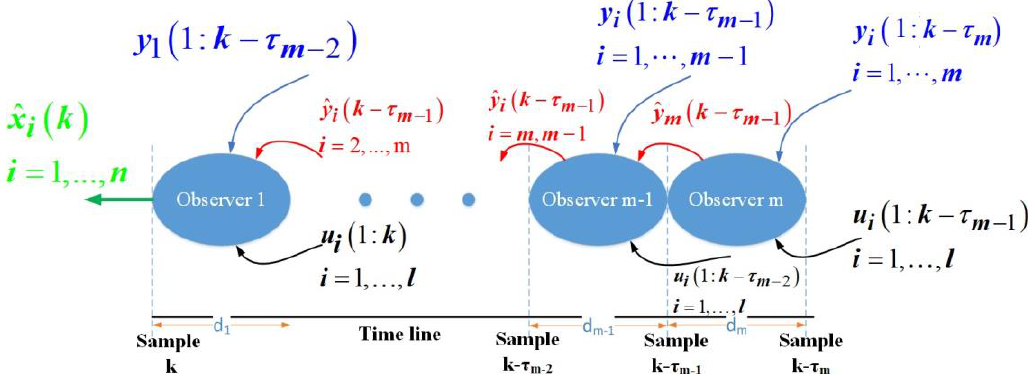
Figure 2. The proposed m chain – observer ( y i (1: s ) is the output i from sample 1 to sample s ).